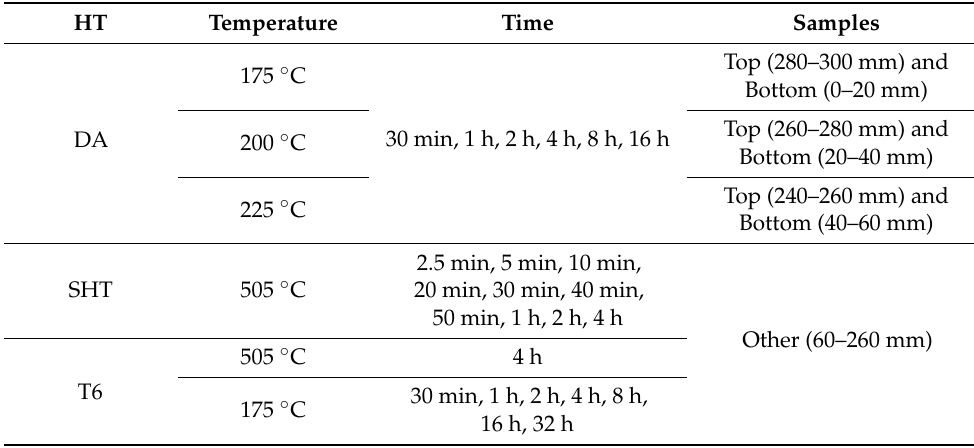
Table 3. Heat treatment performed on AlSi7Mg0.6 and AlSi10Mg0.3 samples. HT Temperature Time Samples 175 ◦ C 30 min, 1 h, 2 h, 4 h, 8 h, 16 h DA 200 ◦ C